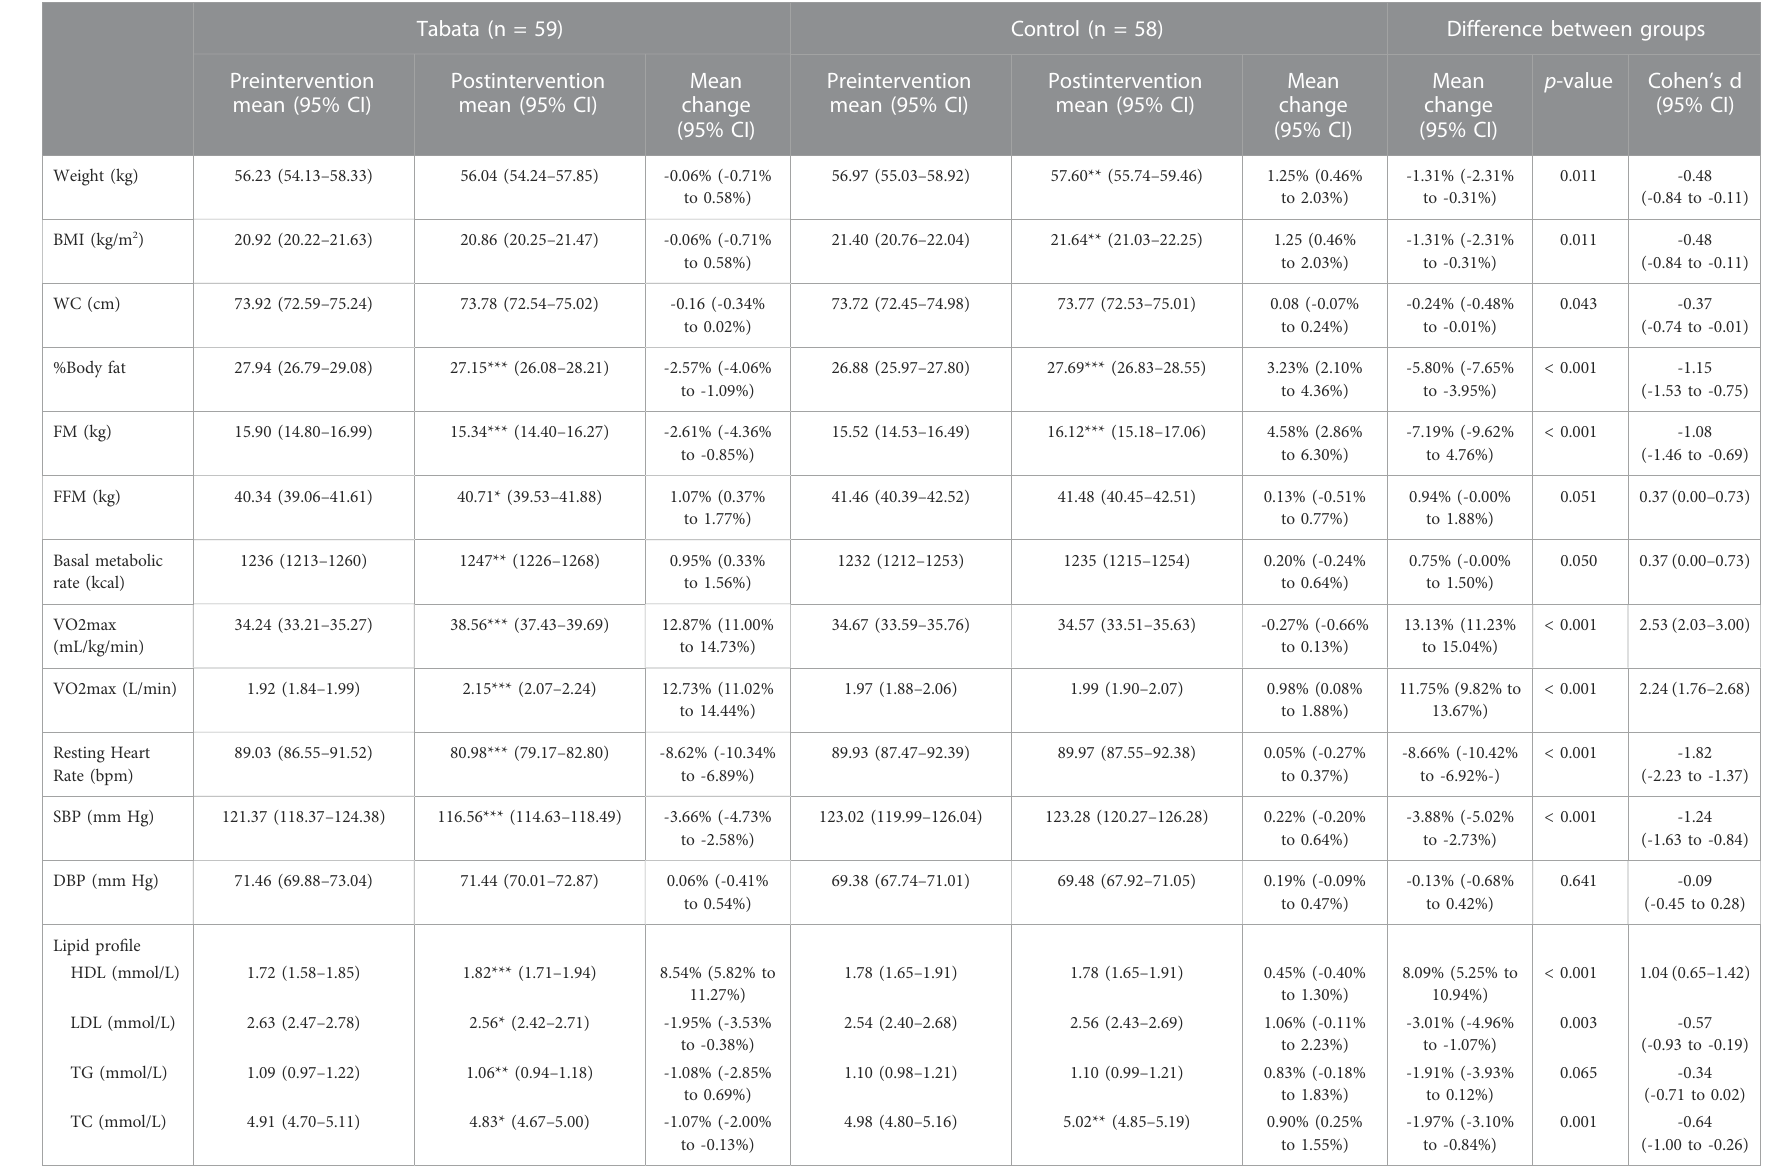
TABLE 2 The effects of the Tabata style functional HIIT between Tabata and control